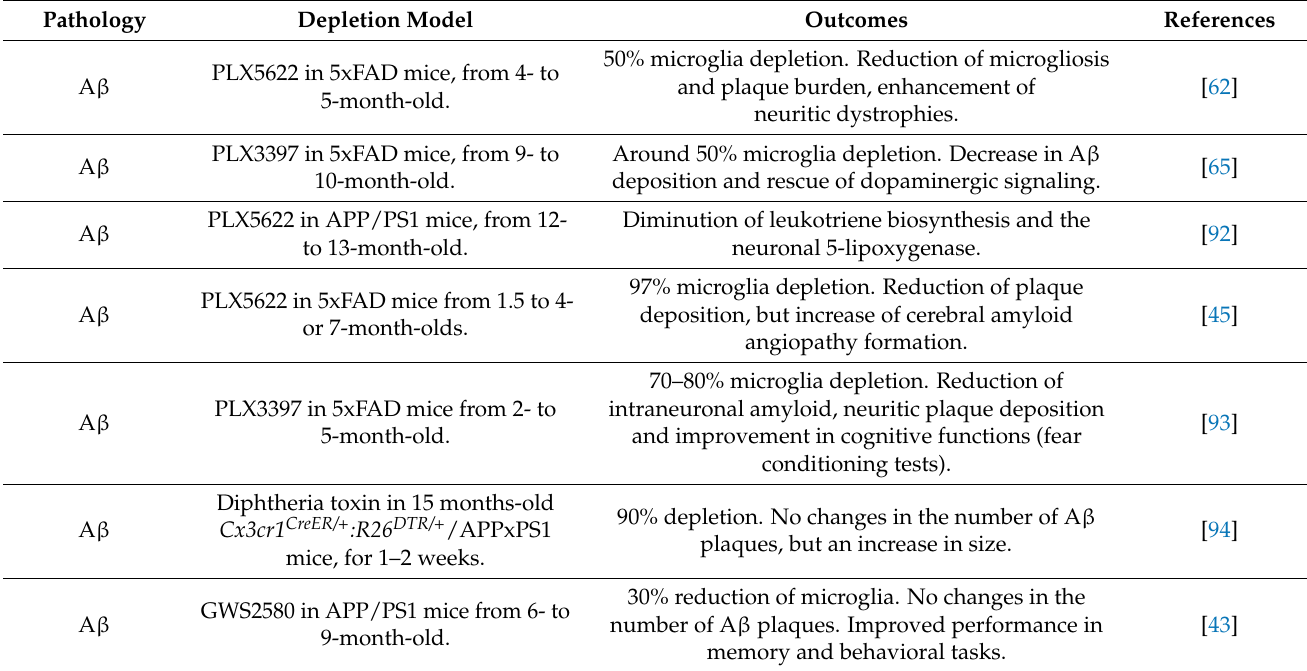
Table 1. Relevant results in AD mouse models of microglia depletion. Mouse models used and main outcomes are shown.